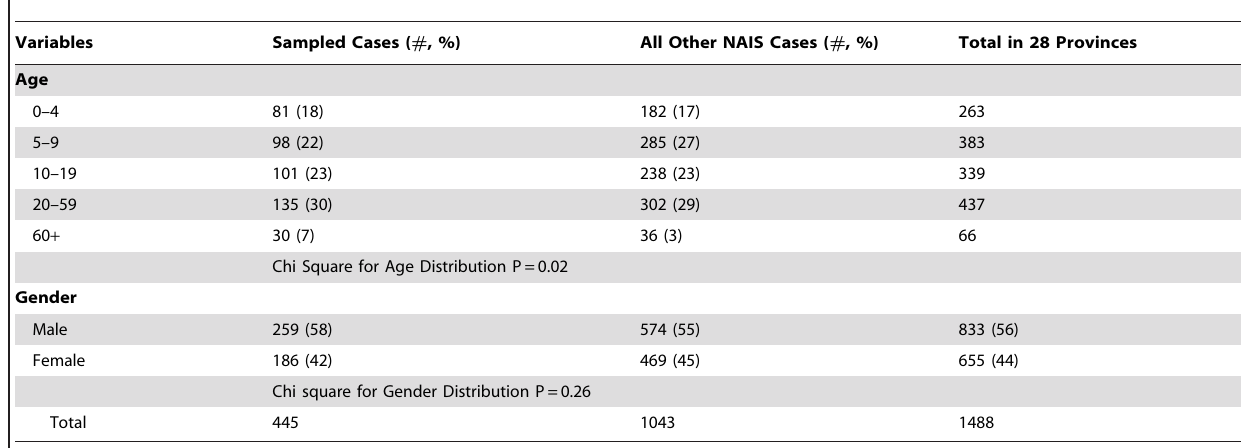
Table 2. Age and gender distribution of sampled cases compared to all cases reported to NAIS in 28 provinces.